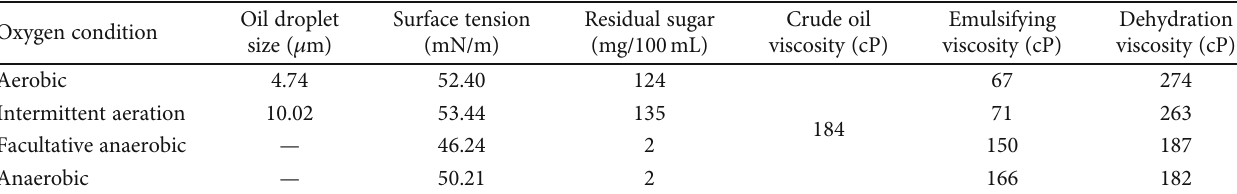
Figure 1: Emulsi fi cation of crude oil in aerobic culture (a), facultative anaerobic culture (b), anaerobic culture (c), and intermittent aeration culture (d). Table 2: Physicochemical properties of di ff erent